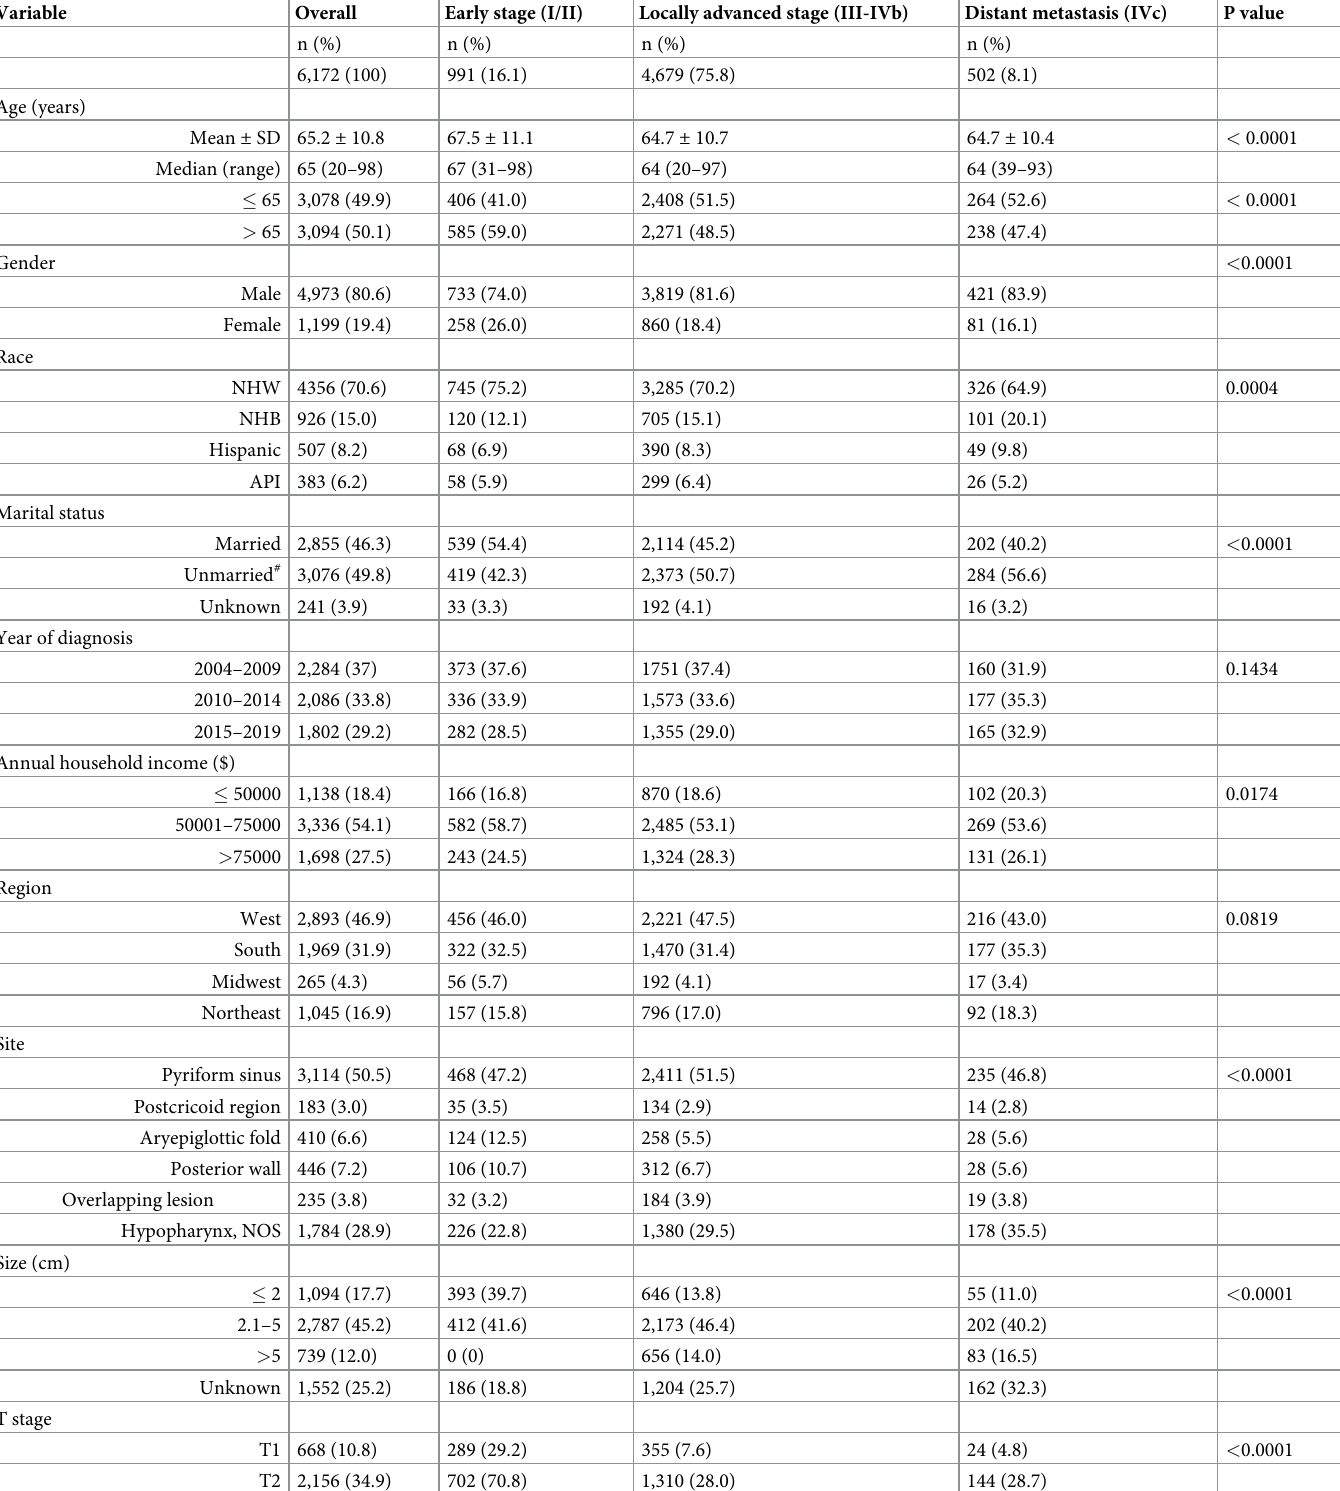
Table 2. Clinicopathological characteristics of patients with HPSCC by stage diagnosed during